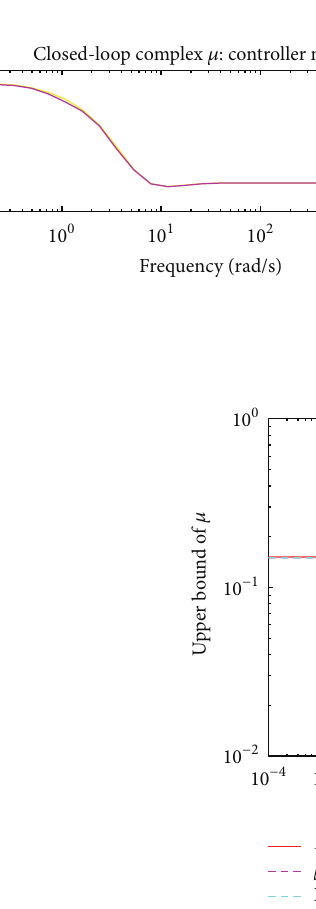
Figure 12: Closed-loop LFTs in 𝐻 ∞ design.